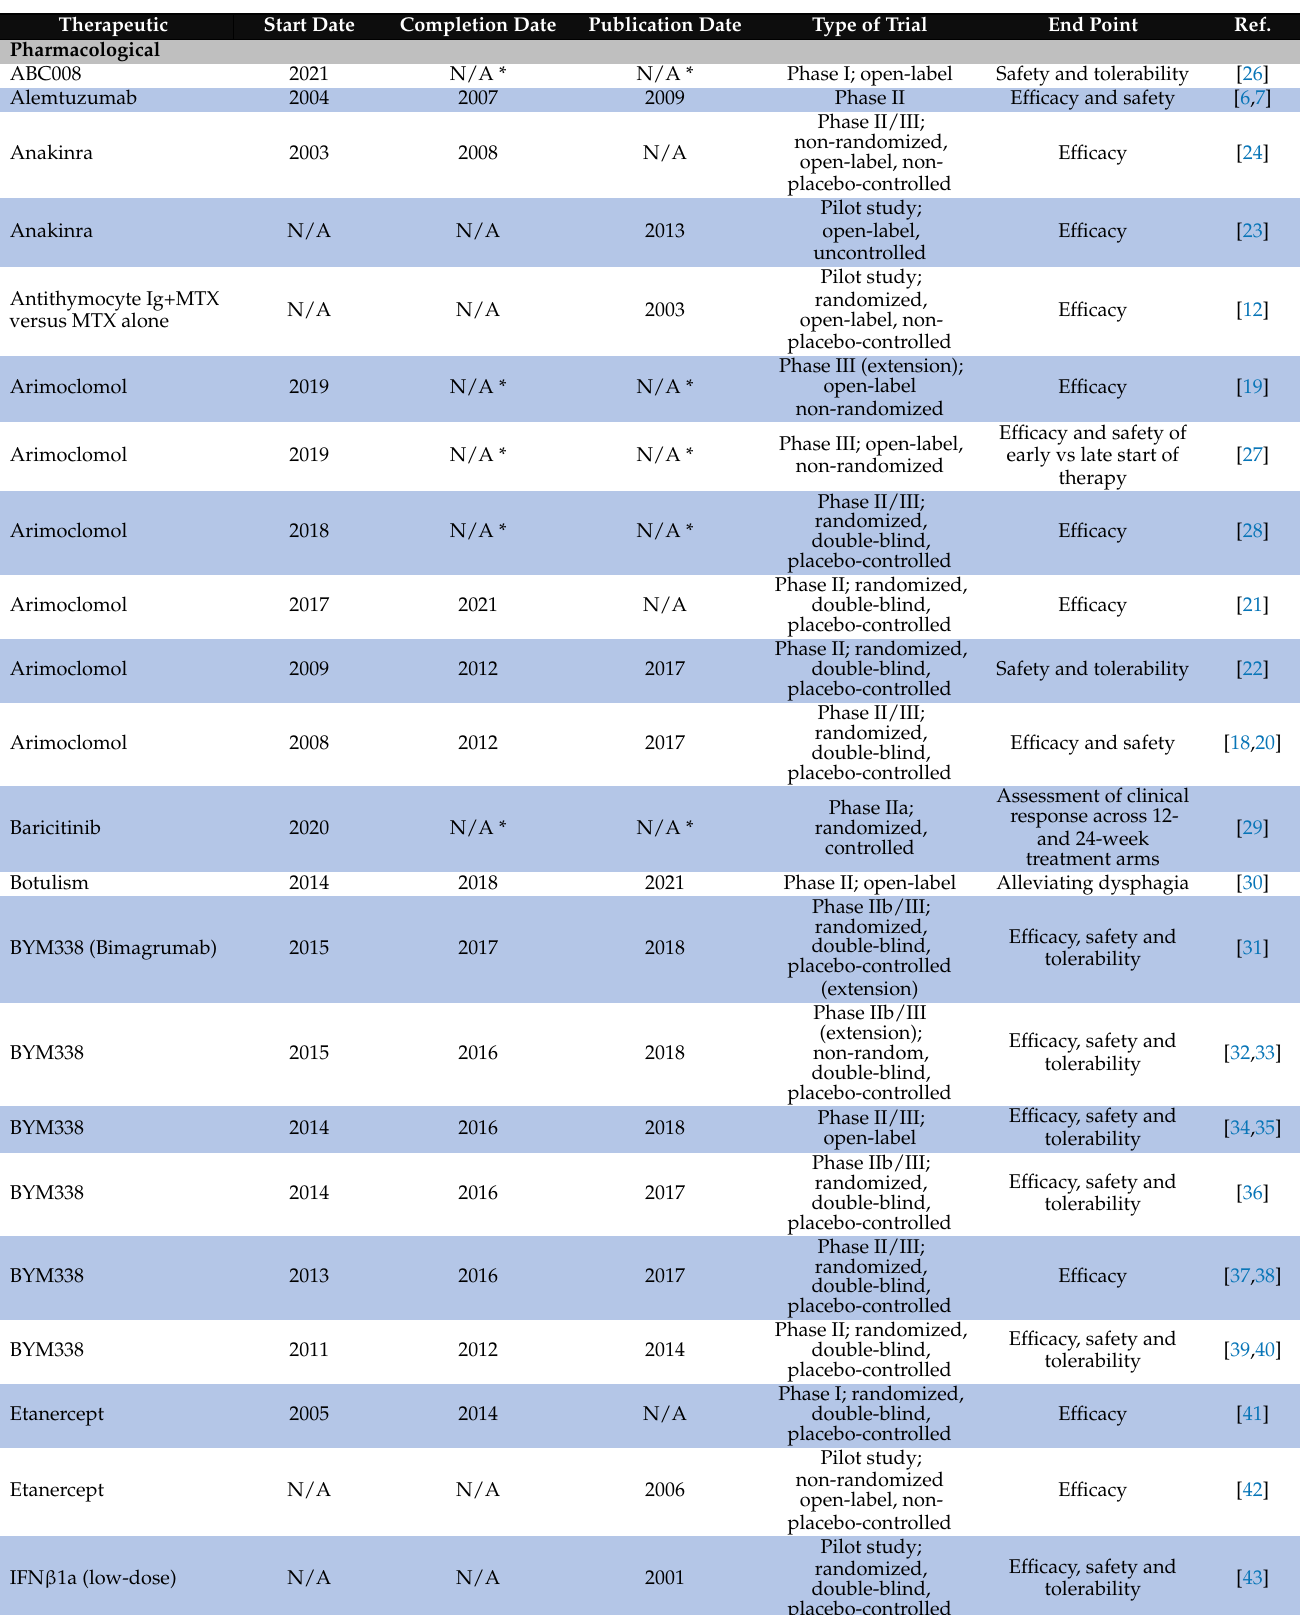
Table 1. Recent clinical trials for IBM in the USA and European Union